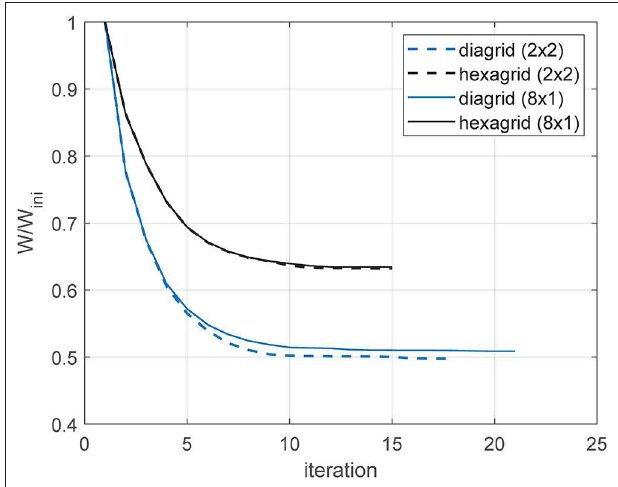
FIGURE 9 | History of the objective function for the optimal distributions of cross-sections shown in Figures 7 , 8 .